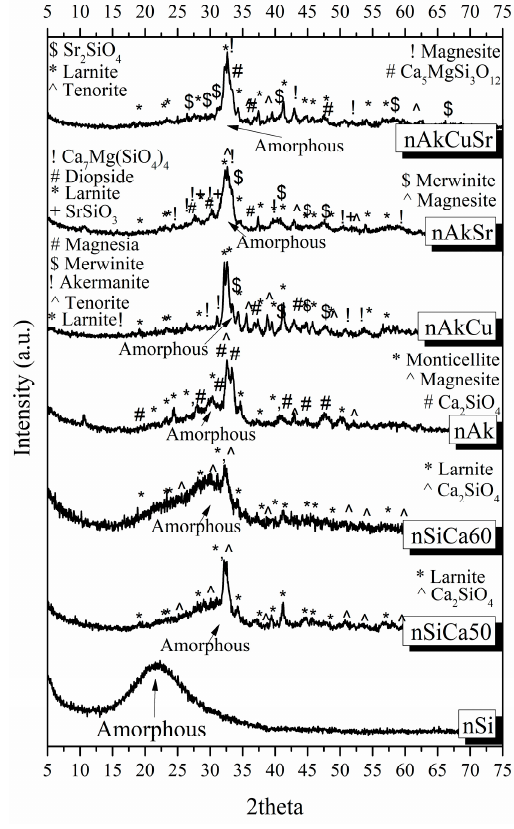
Figure 1. XRD patterns of the synthesized NPs. Table 2. Identification and quantification (in %) of crystalline phases of nanobioceramics.